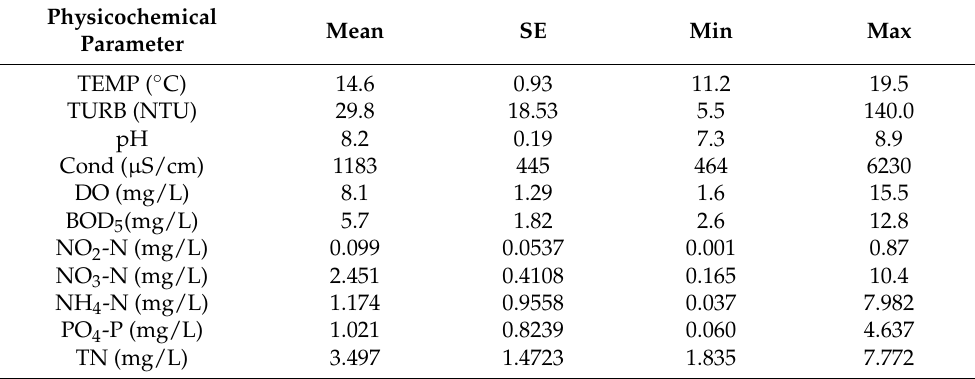
Table 1. Water physicochemical features of Bogdanas River for the period 2010–2017. Data from the monitoring program of the Management Authority of Koronia-Volvi-Chalkidiki and the national monitoring program of the Special Secretariat for